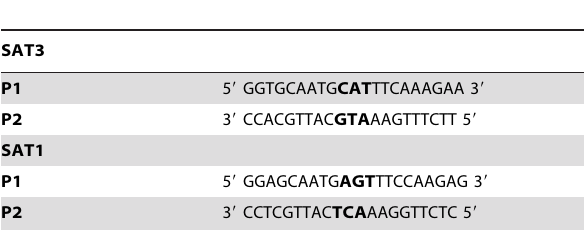
Table 2. Primers used for Site directed